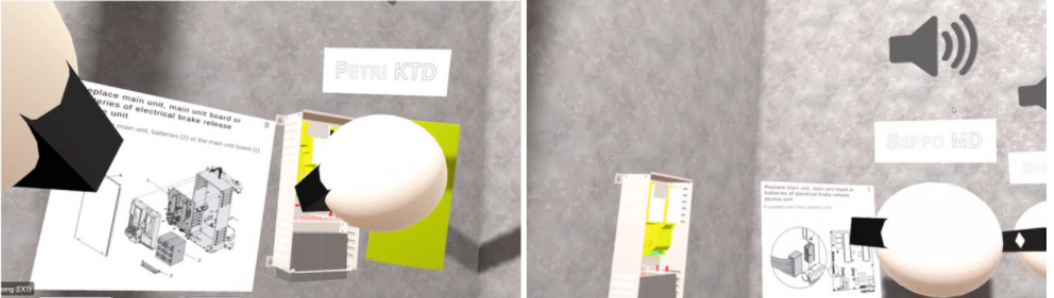
Figure 2. Screenshot of collaborative review of technical documentation in VR. A user is immersed in VR and looking at the avatars of two other users, complete with name labels for